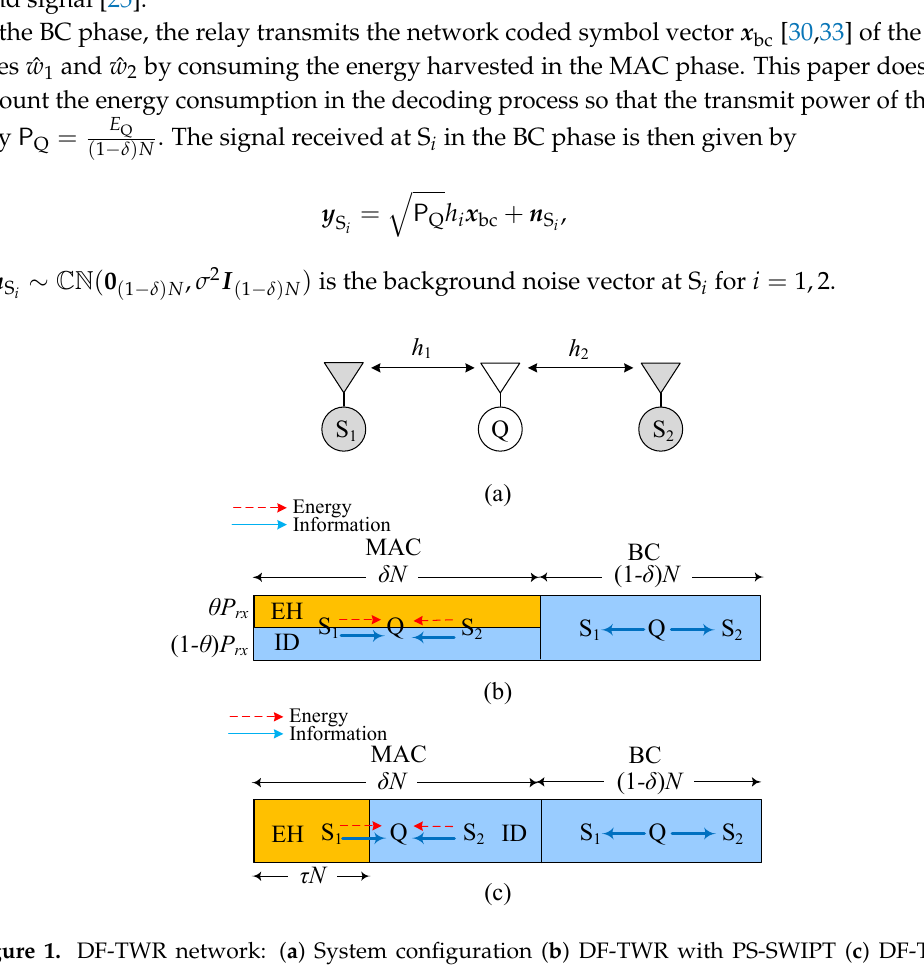
Figure 1. DF-TWR network: ( a ) System configuration ( b ) DF-TWR with PS-SWIPT ( c ) DF-TWR with TS-SWIPT.